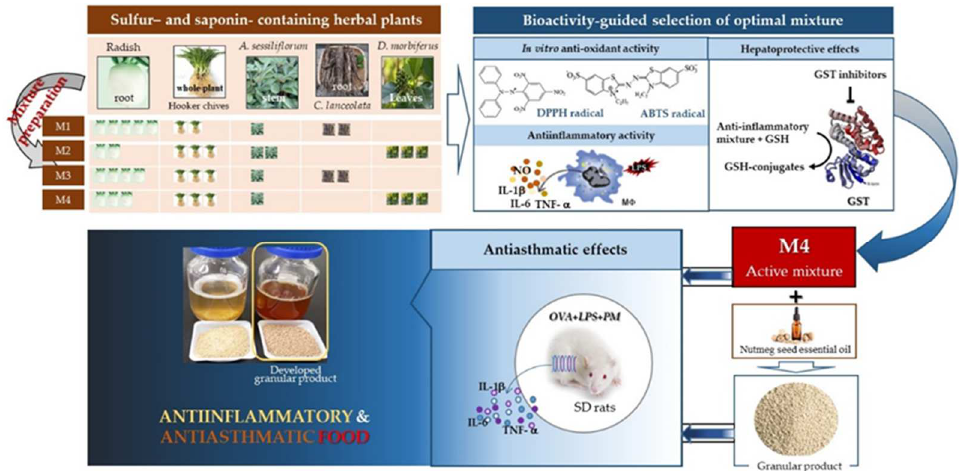
Figure 7. Schematic representation of anti-inflammatory food prepared with mixture of herbal plants and its use in treating asthma.